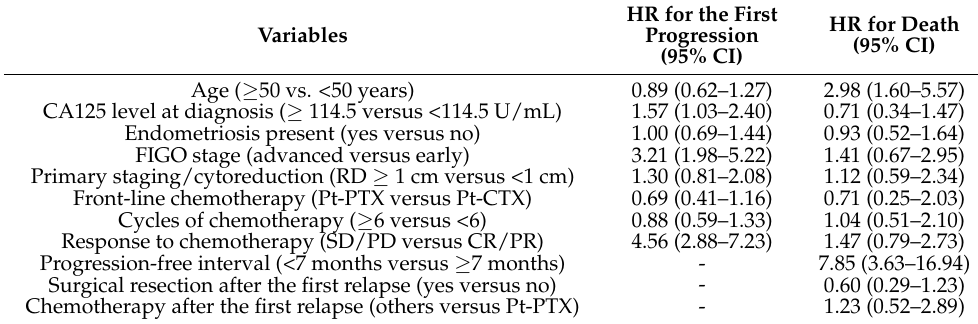
Table 4. Multivariate analysis of prognostic factors in all OCCC patients ( n = 536).